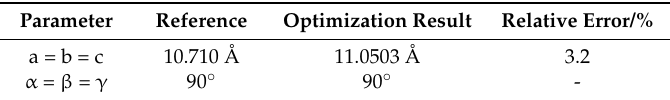
Table 3. Results of cell parameters optimization in DFT calculation and reference (CASTEP module of Materials Studio 6.0 software package, PBE density function, Hubbard + U correction).